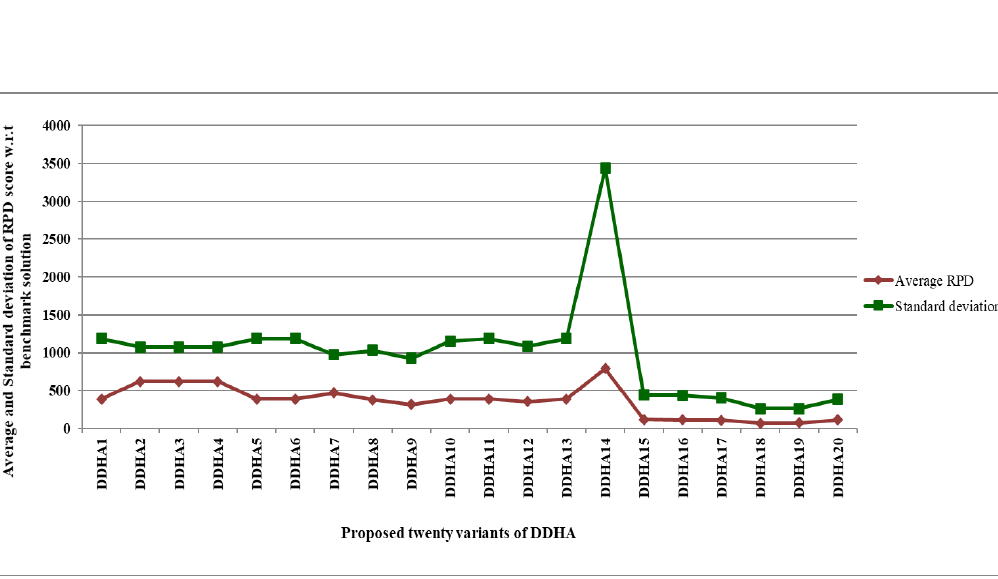
Figure 2. Performance analysis of the proposed 20 variants of DDHA in comparison with estimated optimal solution over 270 problem instances.